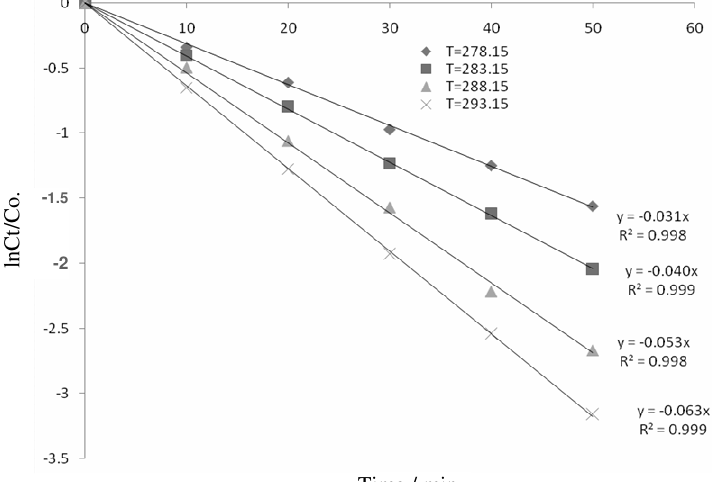
Figure 3. First order plots of photocatalytic decolorization of Bismarck brown G at different